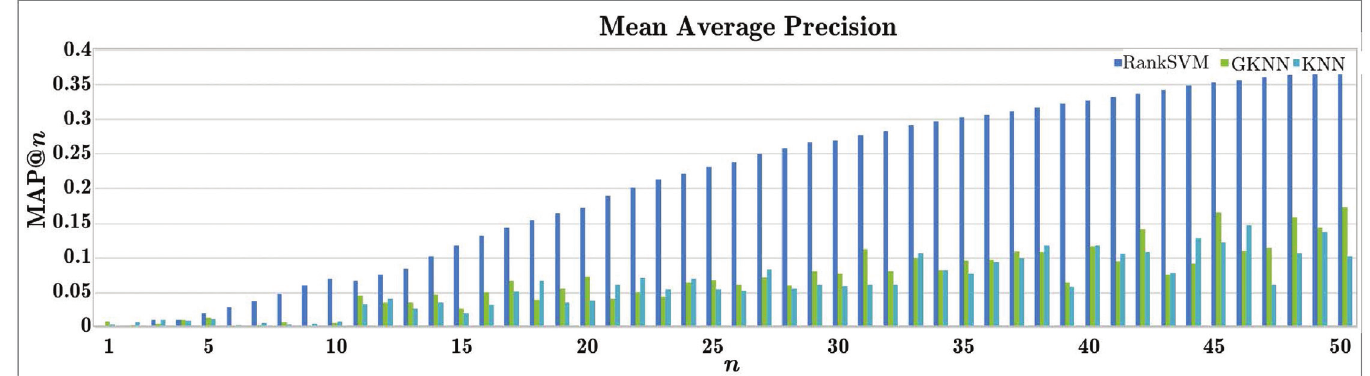
Fig 13. mAP in the gallery data supplementing experiment where data from a random view angle and its mirroring view are discarded for each subject.